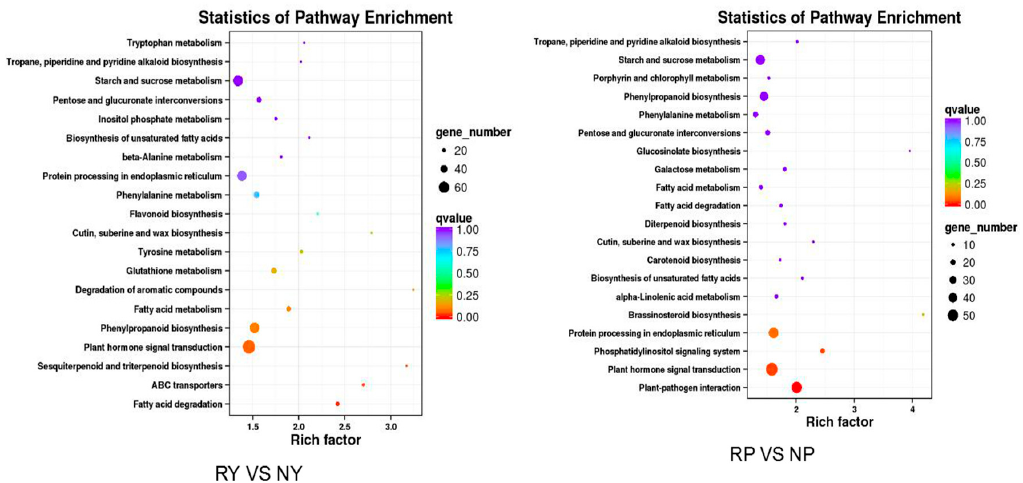
Figure 3. Statistics of KEGG pathway enrichment. Vertical axis shows pathways, horizontal axis shows enrichment factor. Size of dot represents number of DEGs in the pathway. Dot color corresponds to scope of Q -value.